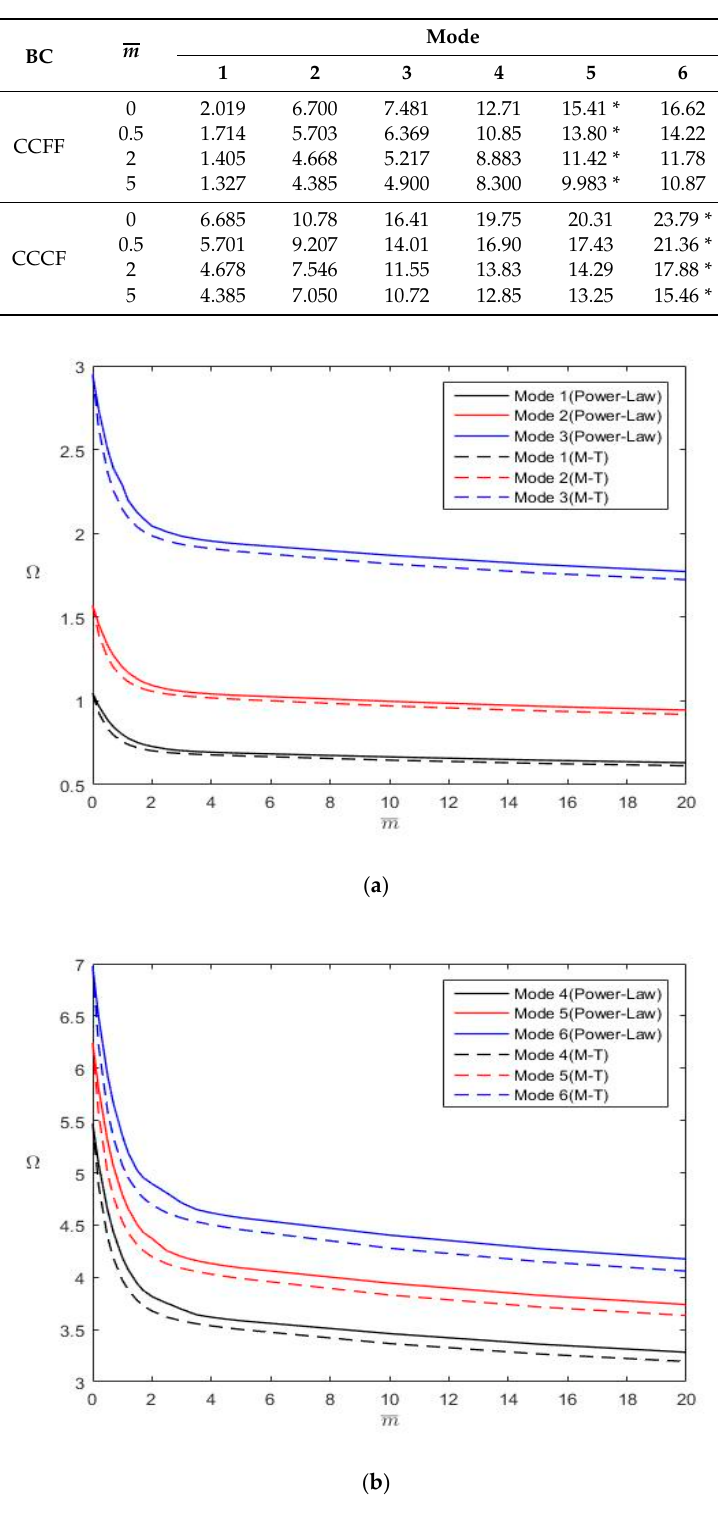
Figure 4. Variations of Ω with m for a CFFF FGM rectangular plate (b / a = 2, h / a = 0.1): ( a ) for modes 1–3; ( b ) for modes 4–6.